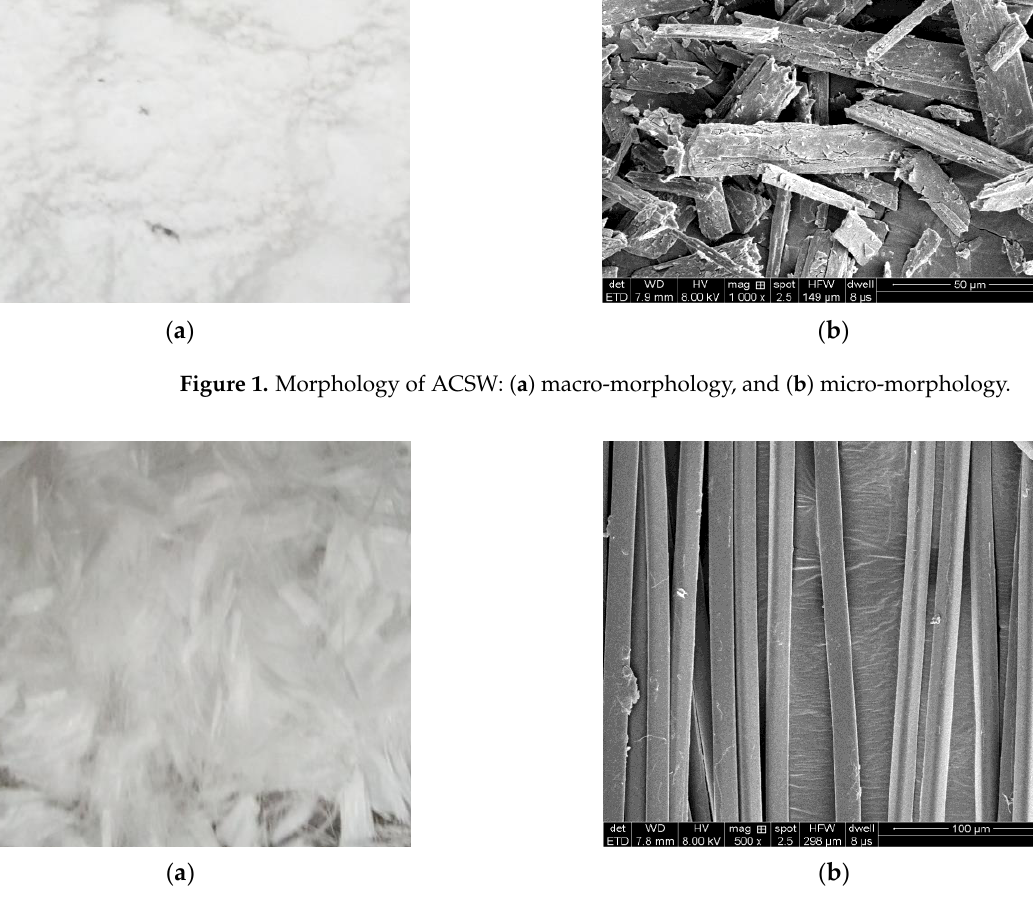
Figure 2. Morphology of polyester fiber: ( a ) macro-morphology, and ( b ) micro-morphology.